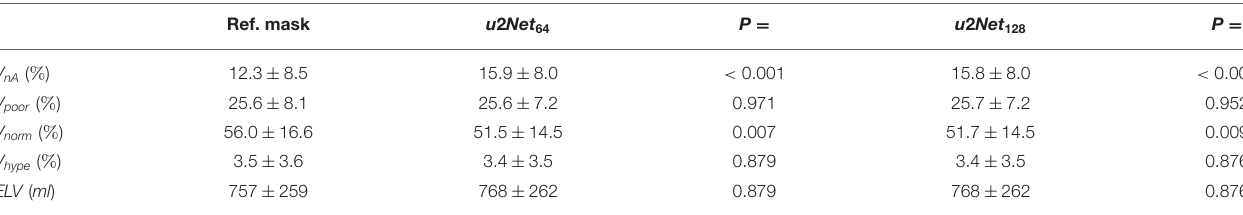
Frontiers in Physiology |